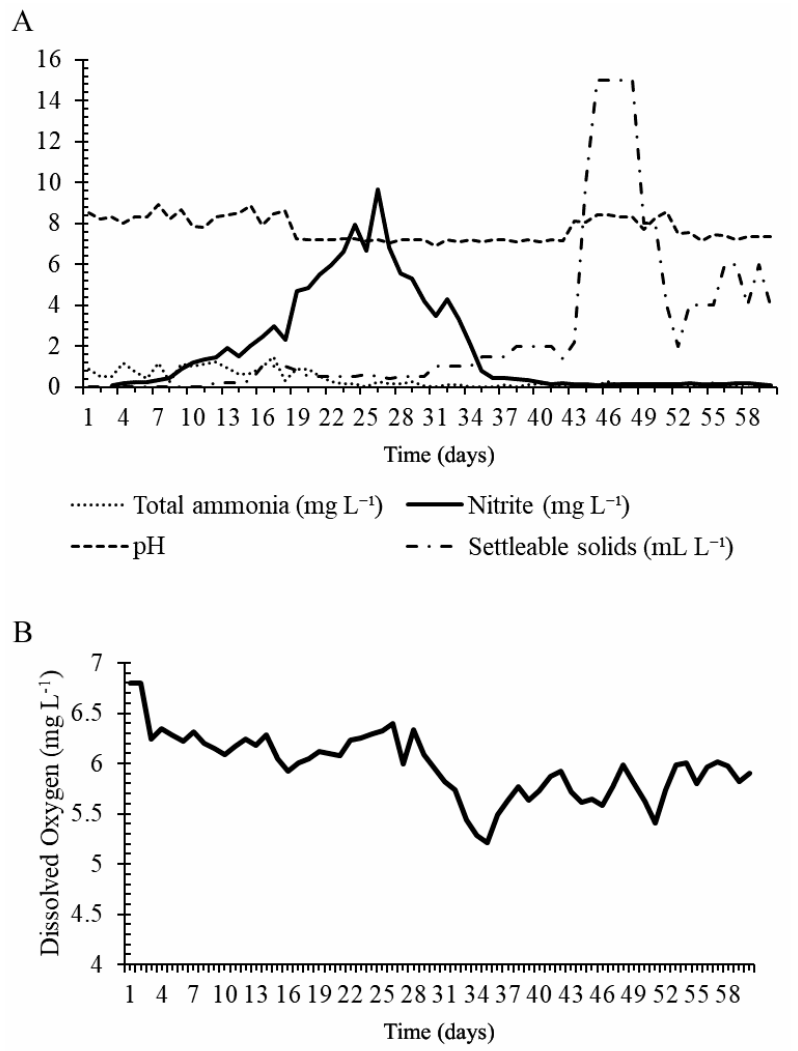
Figure 1. ( A ) Curves for total ammonia (mg L − 1 ), nitrite (mg L − 1 ), settleable solids (mL L − 1 ), and pH during biofloc maturation when rearing Colossoma macropomum juveniles. ( B ) Curve for dissolved oxygen (mg/L) during biofloc maturation when rearing Colossoma macropomum juveniles. During biofloc maturation, the C. macropomum juveniles grew (in both weight and total length) and achieved their highest biomass, and consequently highest production (kg m − 3 ), at the end of the experimental period ( p < 0.05) (Table 1); however, the best